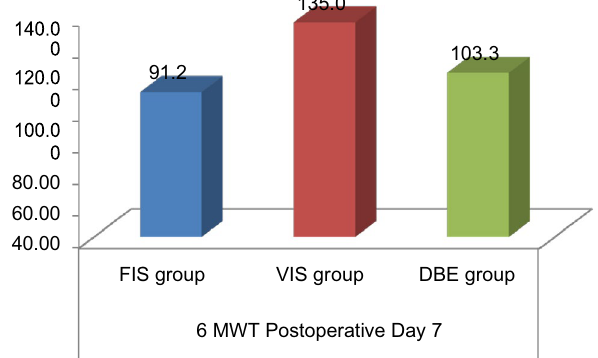
Figure 6. Comparison of 6-Minute Walk Test (6MWT), on post-operative day 7 in the three intervention groups.